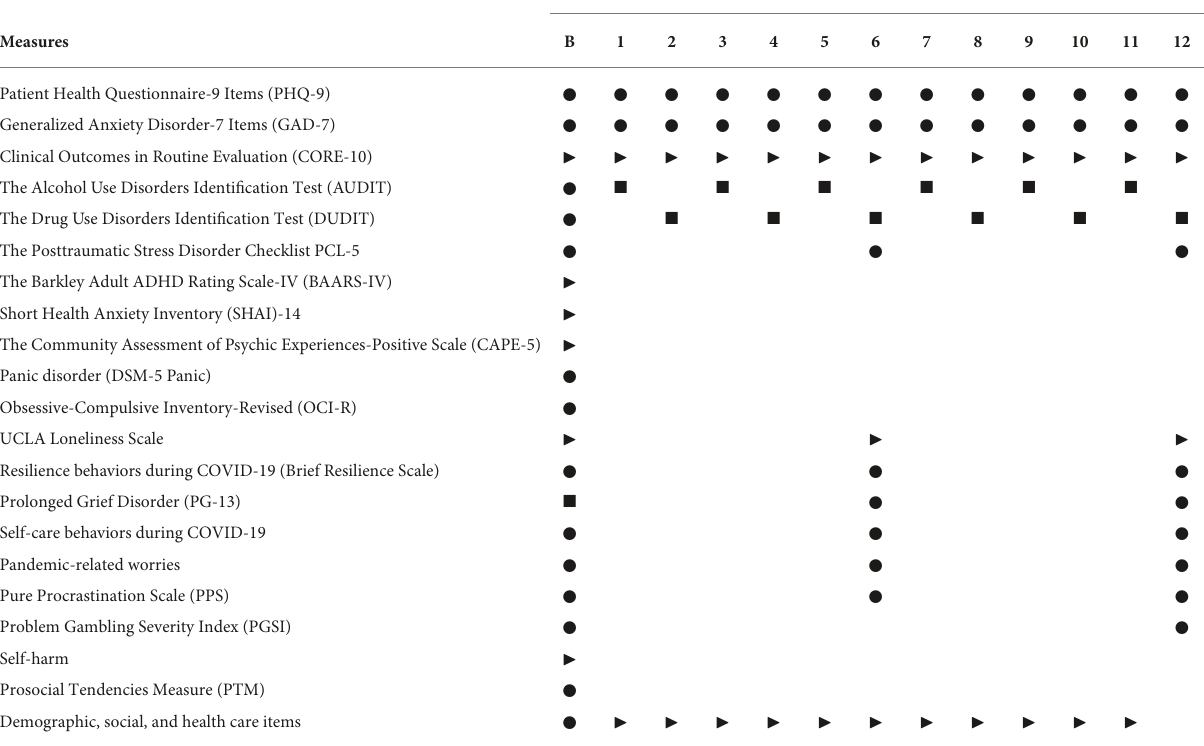
Baseline and follow-up in